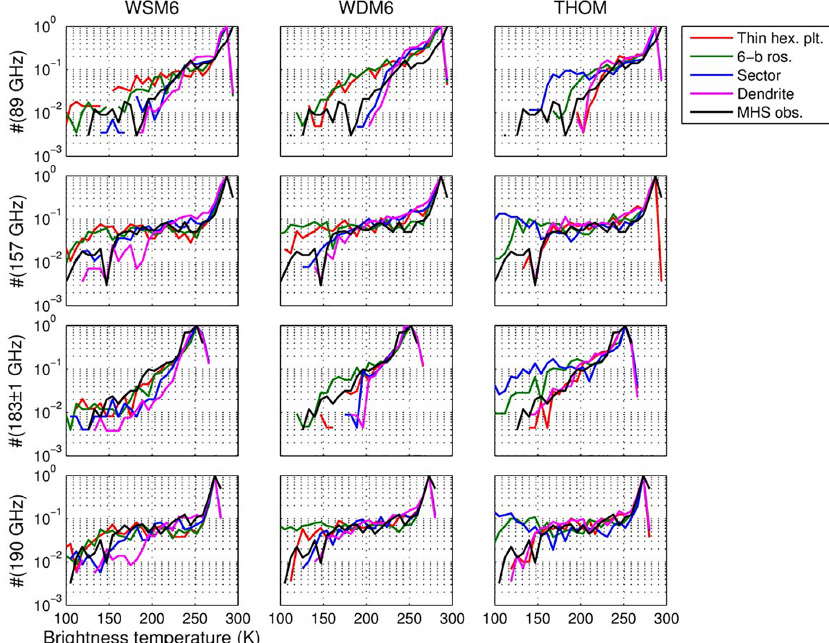
Figure 11. The observed (solid black line) and simulated (solid coloured lines) MHS brightness temperature distributions (built with 5K bins and where bins with less than five values are